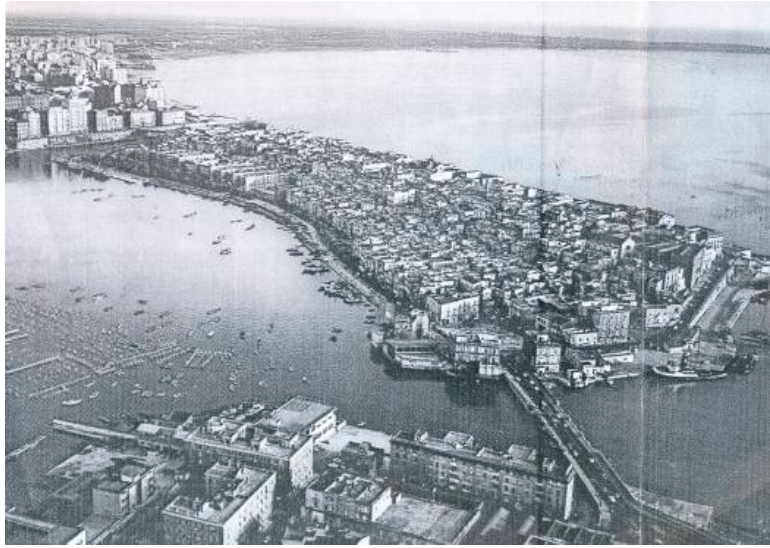
Figure 6. Aerial photography of the city of Taranto in the early 1980s.